Question: What visual encoding does this figure use to show its data?
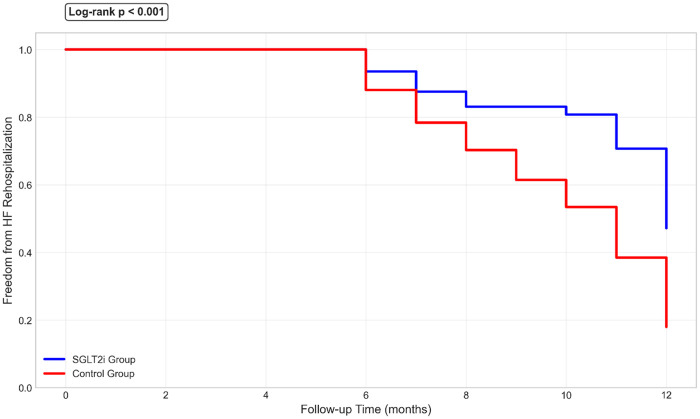
Answer: survival